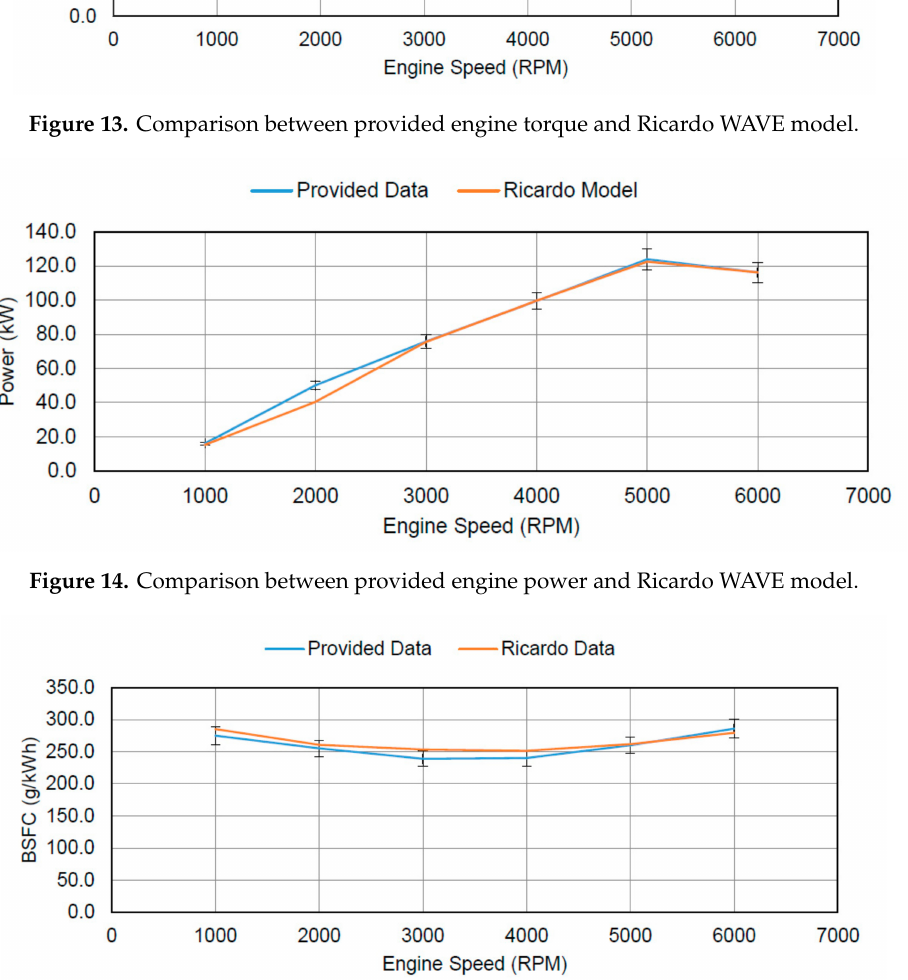
Figure 15. Comparison between provided engine BSFC and Ricardo WAVE